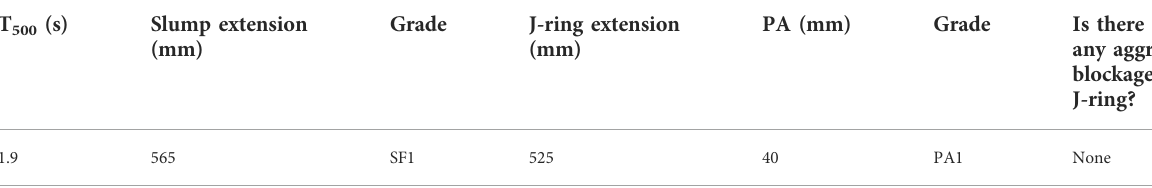
TABLE 5 Test results of the workability of commercial self-compacting concrete.